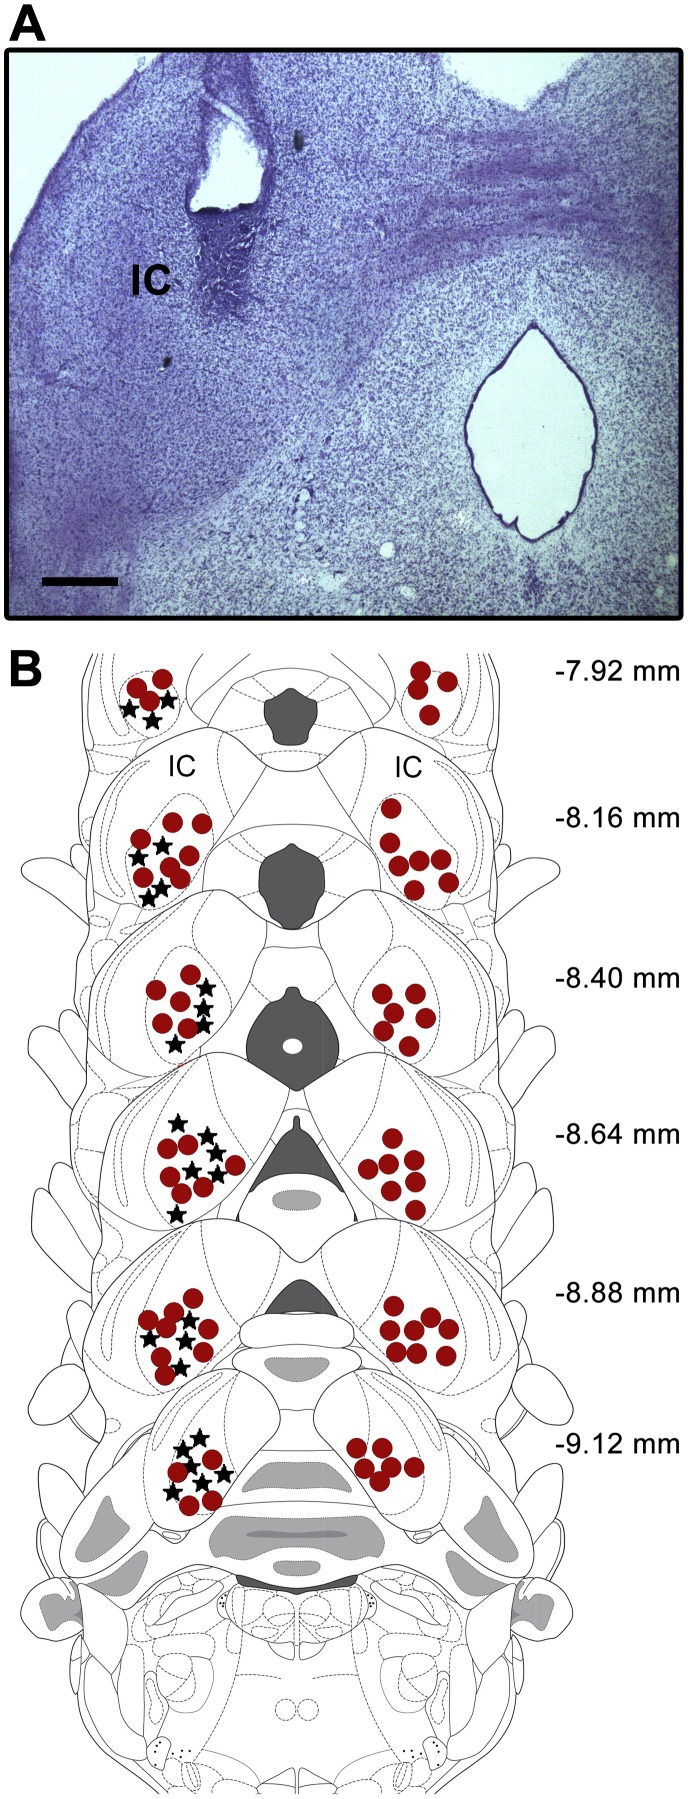
Target microinjection/recording sites in the inferior colliculus.(A) Photomicrograph showing a representative microinjection site in the IC. (B) Outlines of the microinjection and recording sites on coronal brain sections from the Paxinos and Watson atlas (2007) are shown. Symbols of each group were represented in the same side for the sake of clarity. • – injection sites, ★ – recording electrode implants. The number of points in the figure is less than the total number of rats used because several points overlap. Scale bar = 0.5 mm. IC = inferior colliculus.